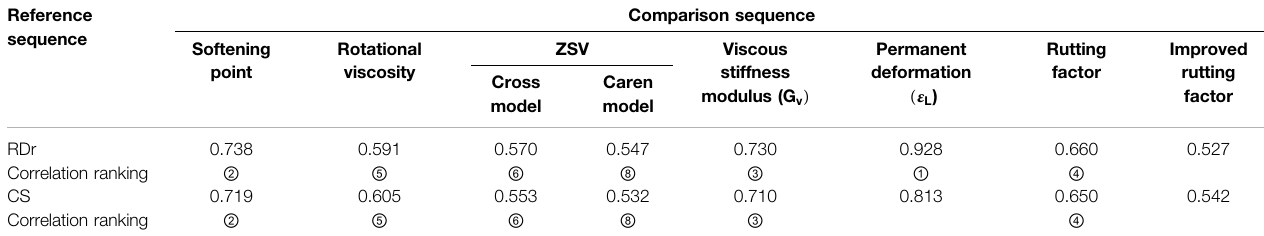
TABLE 9 | Gray correlation degree of each asphalt index and the index in